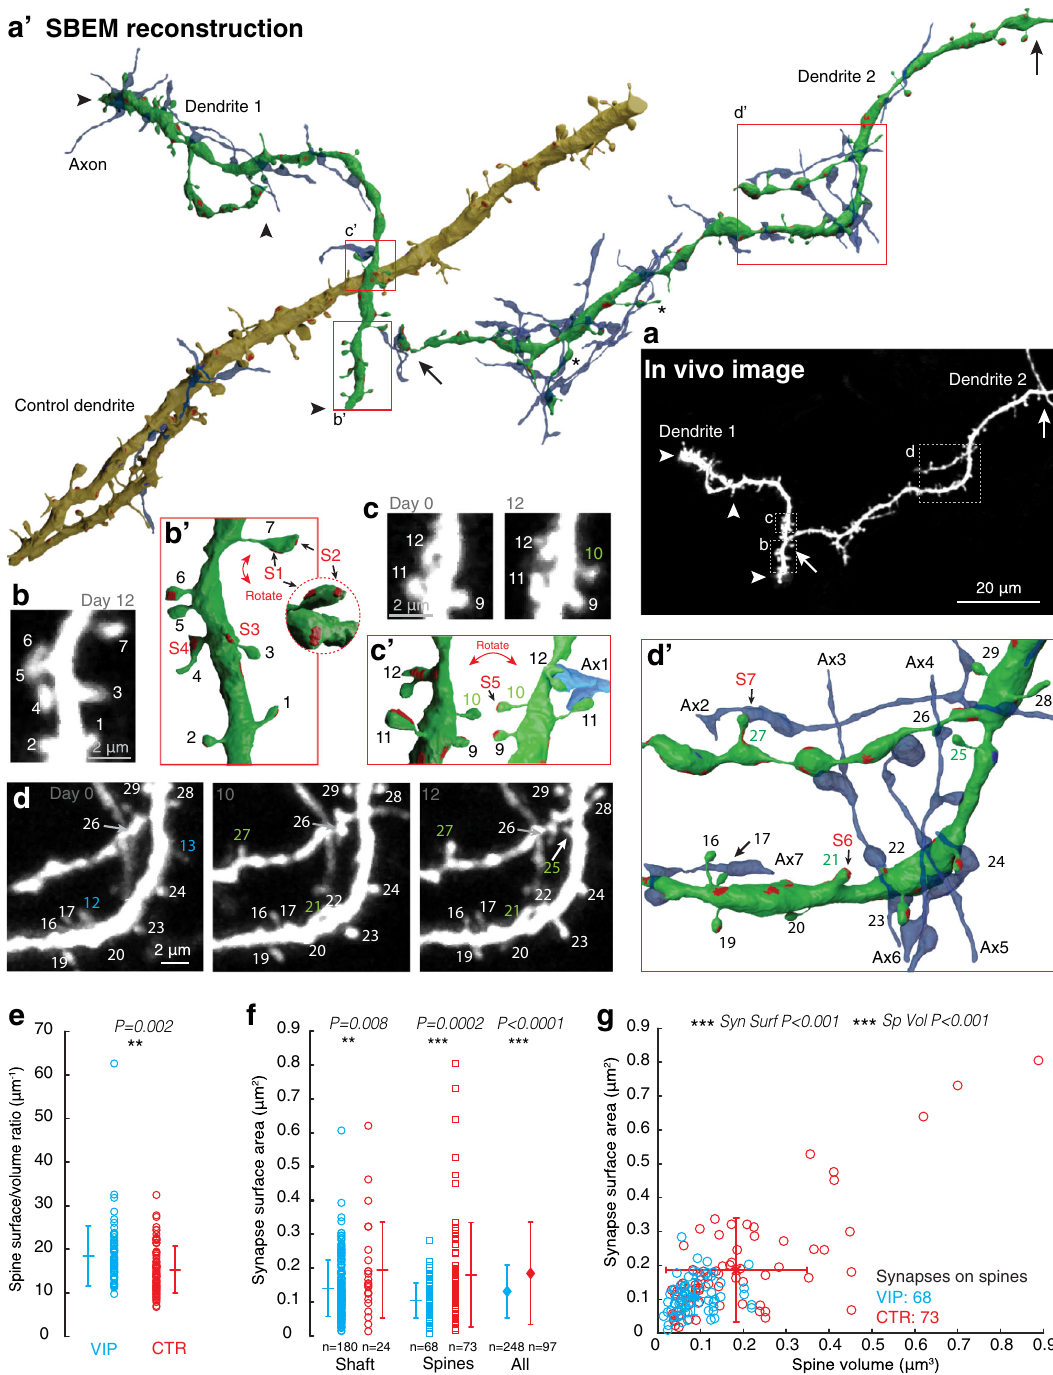
Fig. 6 Ultrastructural analysis of spiny VIP dendrites, their synapses, and compound presynaptic axons. a Best projection of in vivo images of two VIP dendrites. Arrows and arrow heads demarcate the dendritic segments that were reconstructed. ( a ’ ) SBEM reconstructions of the 2 VIP-dendrites (green, dendrite 1, 2) and 1 control dendrite (olive), and their presynaptic axons with compound connections (blue), i.e. more than 1 synapse with the same dendritic segment. Boxes indicate the high-magni fi cation views in ( b – d and b ’– d ’ ). Asymmetric synapses are in red, others in blue. ( b , c , d ) high magni fi cation in vivo images and ( c ’ , d ’ , e ’ ) detailed reconstructions of dendritic sub-regions. Spines are numbered. Green numbers (#10, #21, #25, and #27) represent newly formed spines. Blue numbers (#12 and #13) are spines that were lost over the time frame of imaging. Axons with multiple connections are in blue and numbered (Ax1, Ax2 etc). e The spine surface-to-volume ratio is signi fi cantly larger for VIP spines as compared to CTR spines. f Excitatory synapse surface of shaft and spine synapses is signi fi cantly smaller on VIP dendrites as compared to CTR. g The relationship between spine volume and excitatory synapse